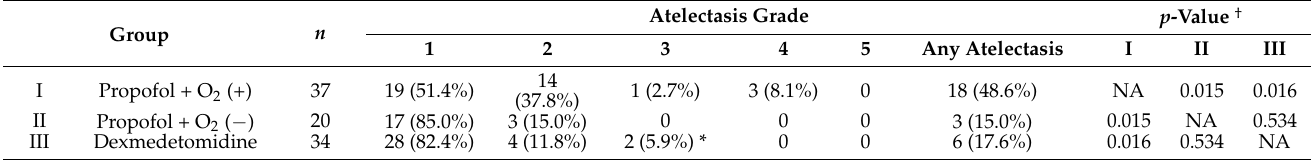
Table 3. Rate of atelectasis occurrence according to the atelectasis grade on initial images.